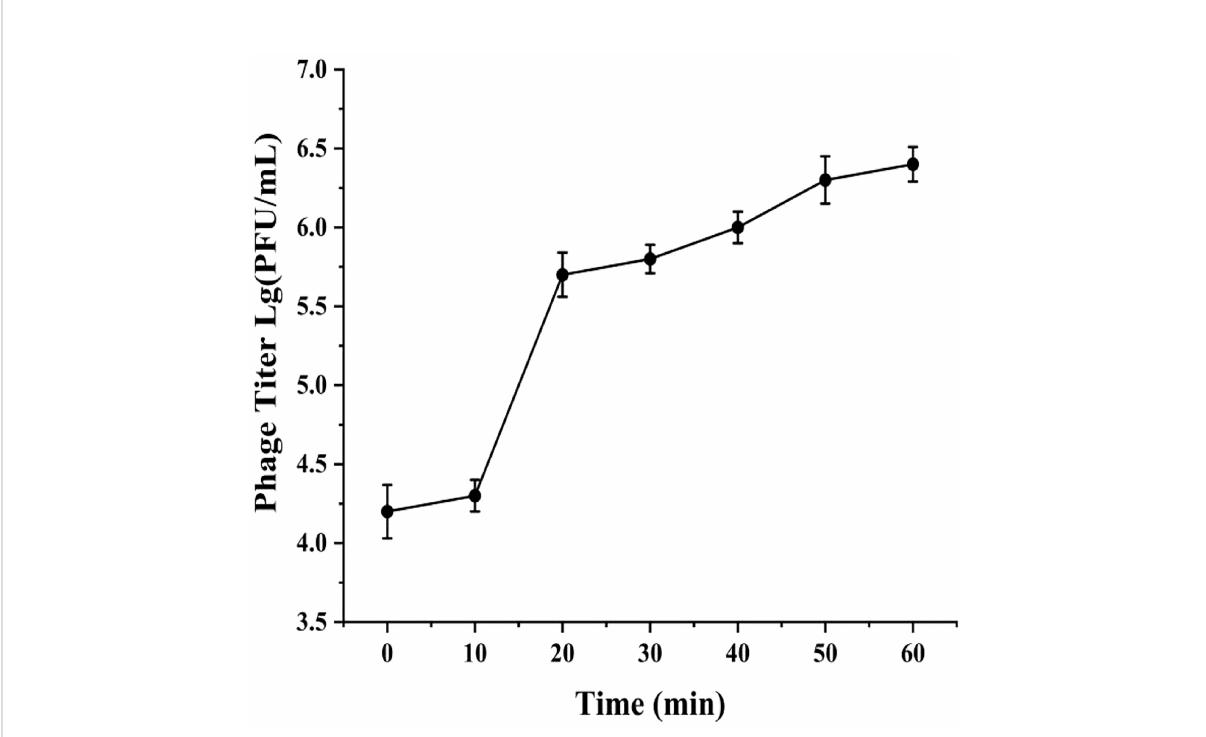
FIGURE 2 One-step growth curve of phage phiTY18. Each data point is the average of three independent experiments, and error bar represent standard